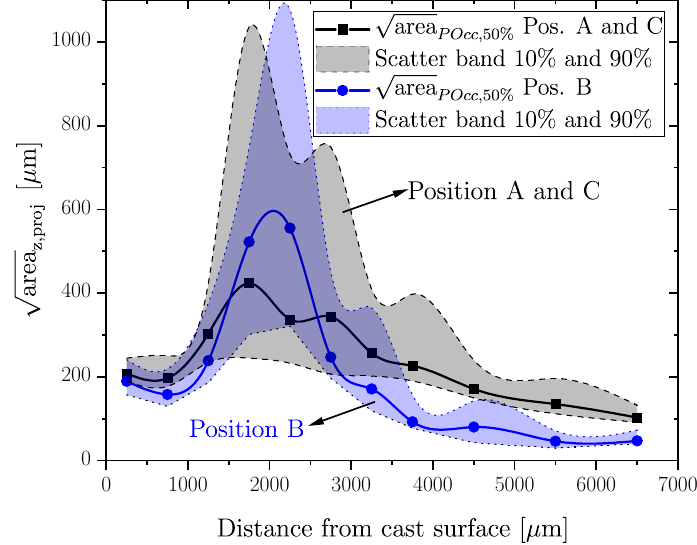
Figure 9. Distribution of the porosity size in a cross section of the thick-walled specimen geometry for extracting Positions A to C.